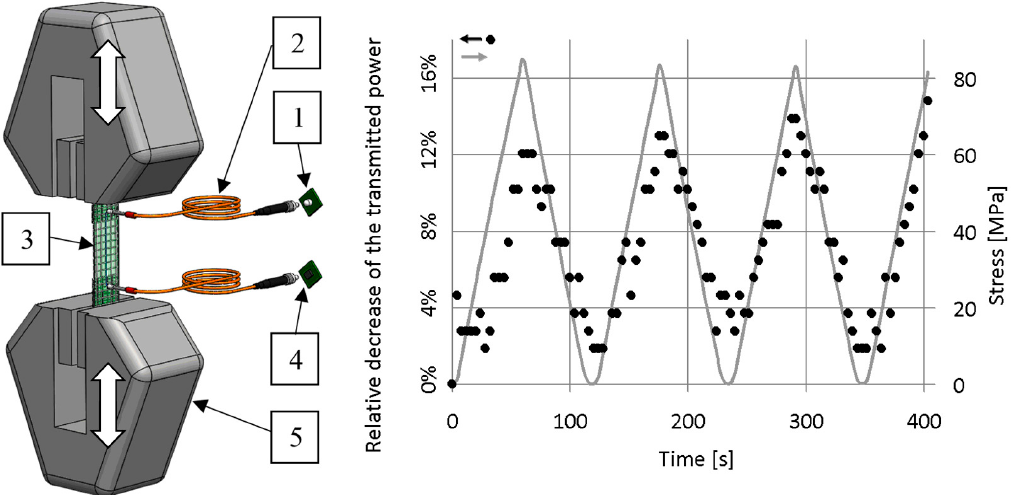
Figure 6. Cyclic tensile measurement layout (1: light source, 2: signal transmitter (polymer optical fibre), 3: specimen, 4: photodiode, 5: clamp of the tensile machine) and a typical plot.